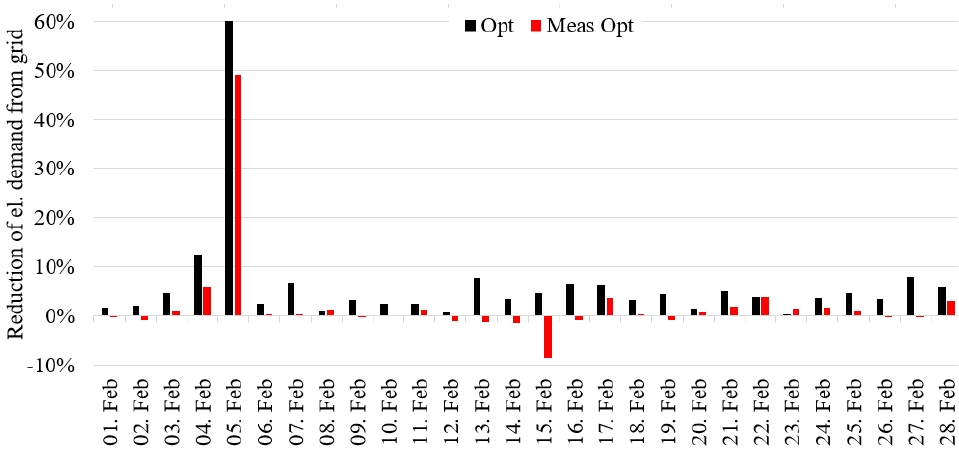
Figure 11. Daily optimization improvement (PV and wind) for a building cluster with normal storage size for the month